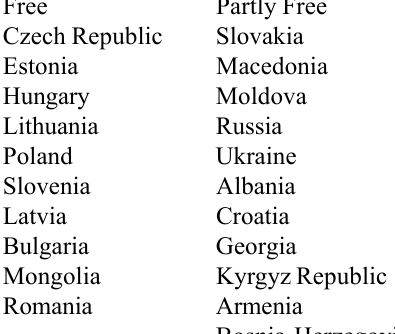
Table - Freedom Status of Post communist Countries Free Partly Free Nor